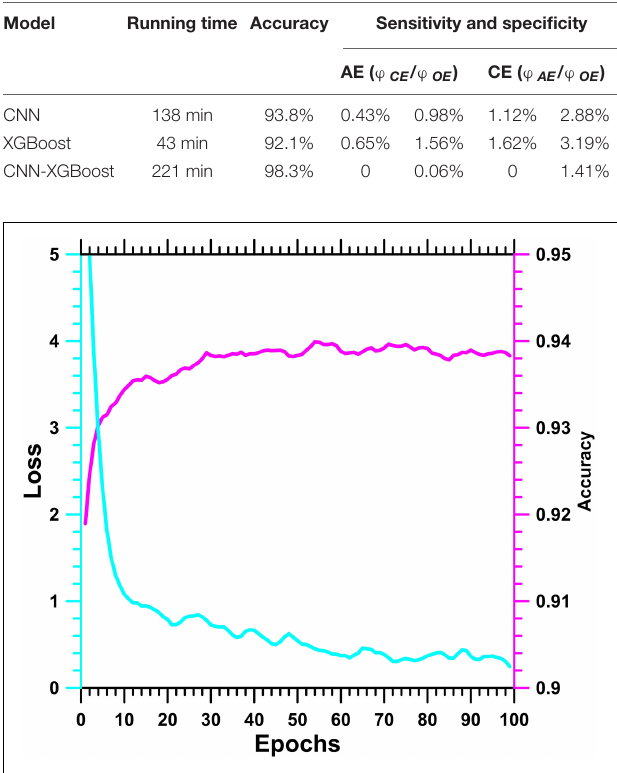
FIGURE 4 | Accuracy and loss variation on validation sets of convolutional neural network (CNN) model.